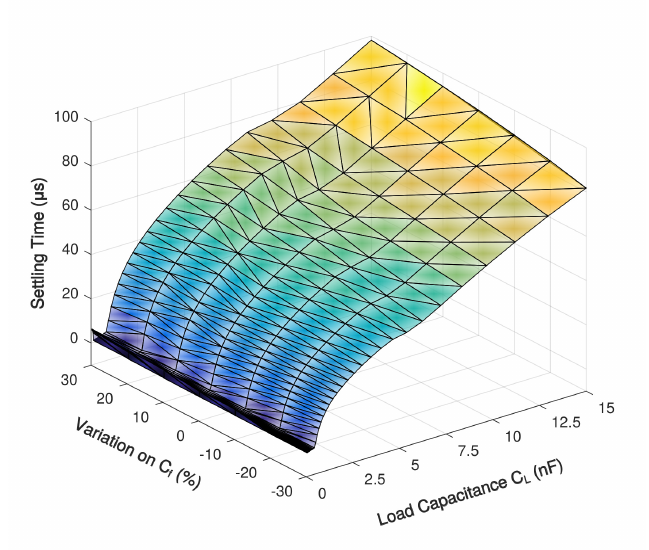
Figure 17. Simulated 1% settling time of the proposed amplifier with 0.1–15-nF load capacitance over Miller compensation capacitor